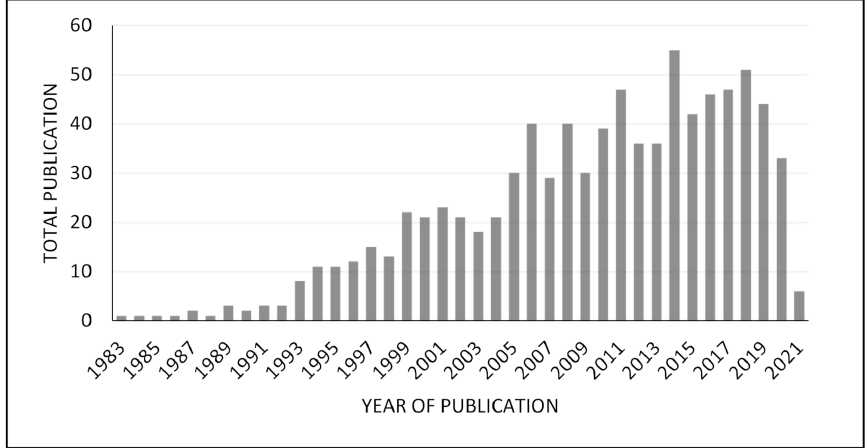
Figure 3. Bibliographic research in Pubmed for amino acid co-crystals